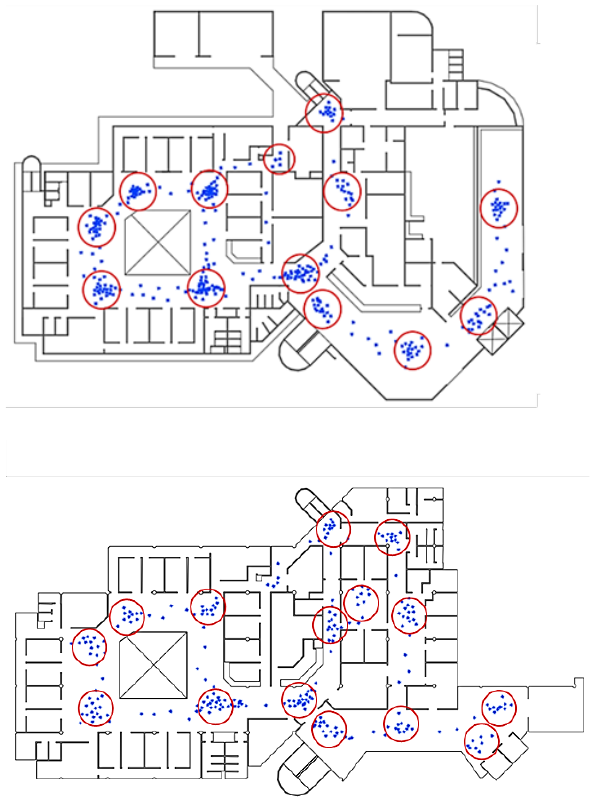
Figure 10. Illustration of the location of the pauses mapped on the building layout of the 1st VRE. It is worth mentioning that more pauses were registered in the ground floor than the first floor due to the fact that all the users had to exit and visit certain areas such as the laboratory and the pharmacy. The locations where the subjects opted for calling an orientation map of maps re- quirements were also mapped on the building layout, indication areas where the subjects struggled with their orientation with respect to both their starting points or their destina- tions; see Figure 11.